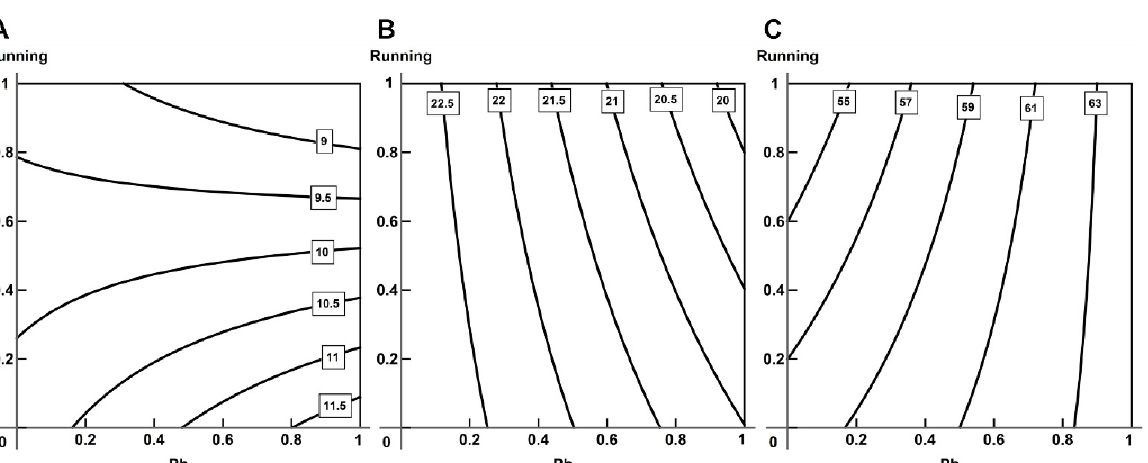
Figure 14. Variability of combined action of running and lead intoxication on ( A ) passive tension (single-factor action of running at low doses of lead changes to opposite and additive at high doses), ( B ) maximal normalized rate (single-factor action of lead at low doses changes to additive at high doses), ( C ) time of relaxation to 50% amplitude of tension (opposite action of lead at low doses changes to single-factor action at high doses) for L = 1.0 Lmax in papillary muscles. Regression equations are y = 10.248 + 1.562 x 1 − 0.951 x 2 − 2.516 x 1 x 2 for ( A ), y = 23.002 − 1.990 x 1 − 0.135 x 2 − 1.130 x 1 x 2 for ( B ) and y = 58.0 + 5.60 x 1 − 5.0 x 2 + 5.111 x 1 x 2 for ( C